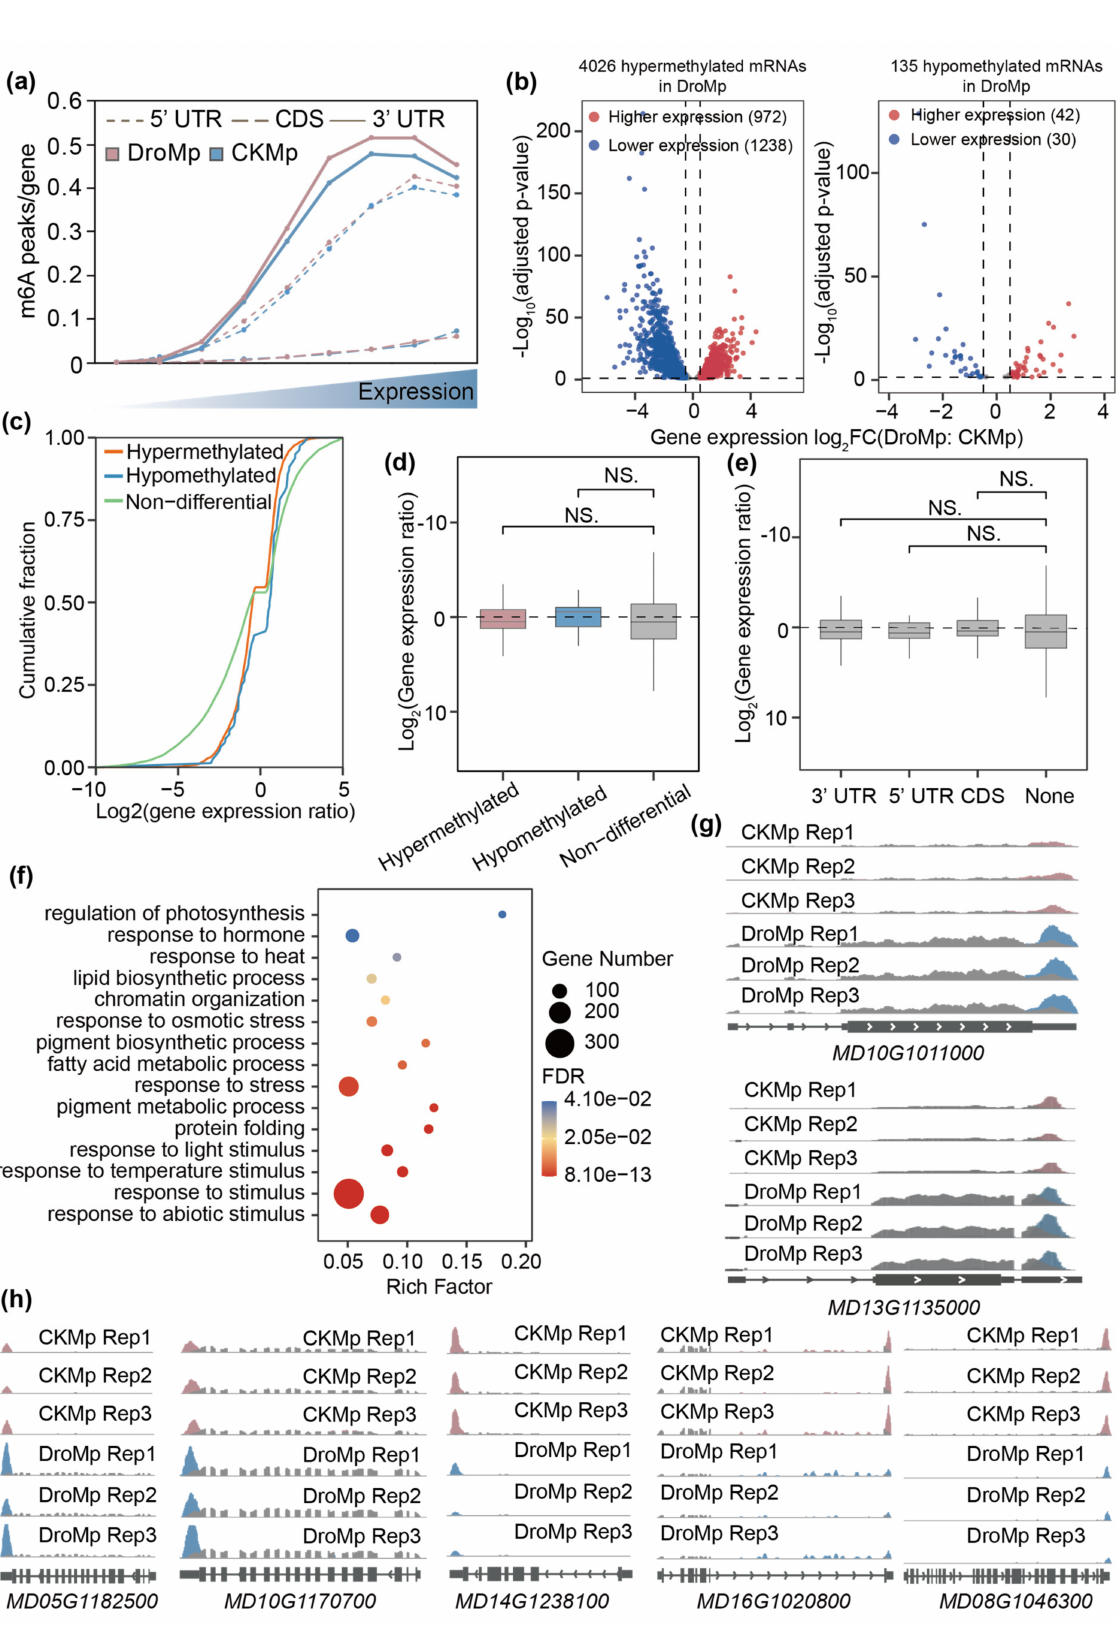
Figure 5. Correlation between m 6 A modification levels and mRNA abundance in M. prunifolia